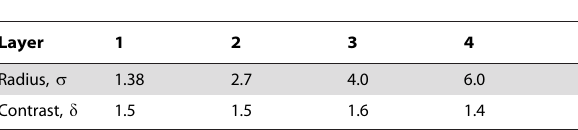
Table 2. Lateral inhibition